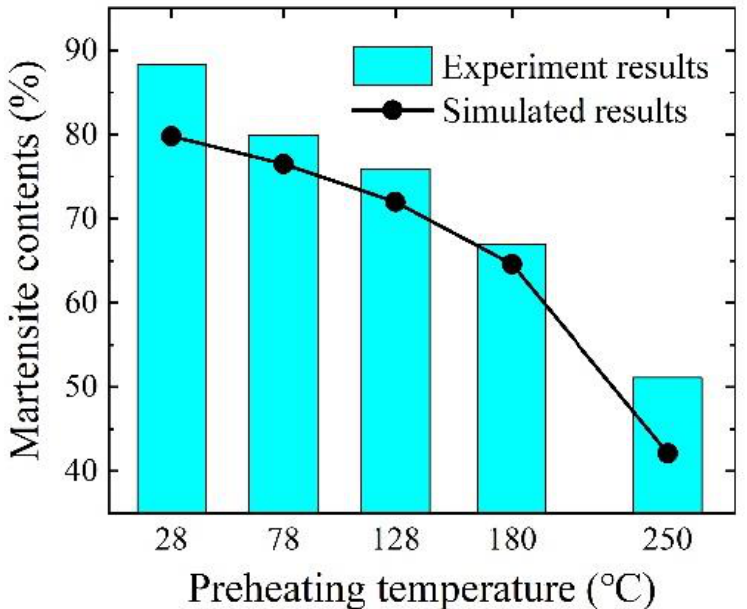
Figure 12. Comparisons of simulated and experimental martensitic contents.